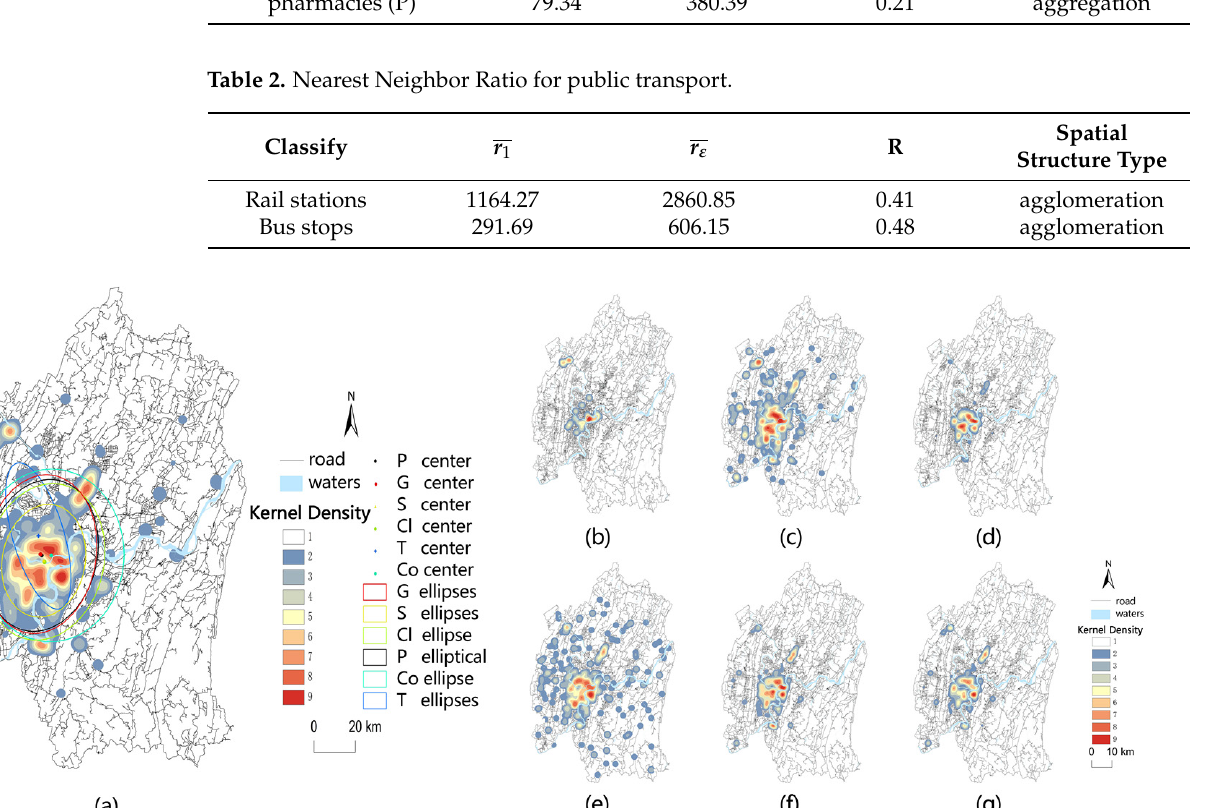
Figure 4. Kernel density analysis chart of public transport stations: ( a ) general public transport sta- tions; ( b ) bus stops; ( c ) rail station.